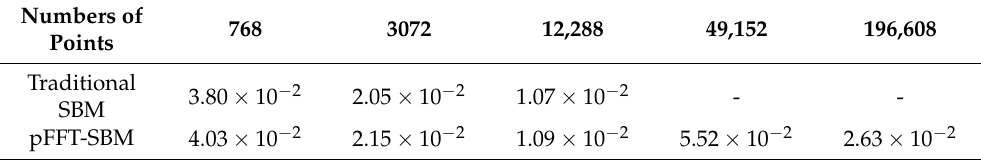
Table 1. The relative errors of the traditional SBM and new pFFT-SBM for example